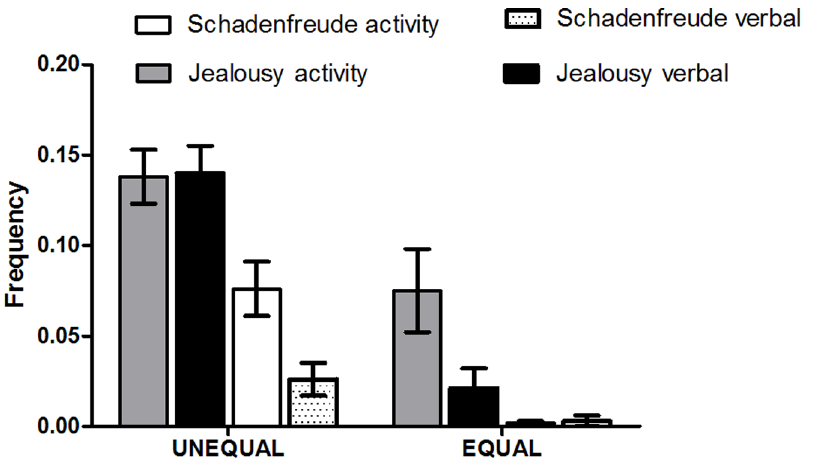
Figure 3. Quantity of different emotional manifestations. A significant interaction of phase (phase 1, phase 2)*condition (EQUAL, UNEQUAL) * category (verbalization/action) . Follow-up paired t tests indicated that the differences between the UNEQUAL and the EQUAL condition were evident in the action phase 1 ratings, verbalization phase 1ratings, in the phase 2 action ratings and phase 2 verbalization ratings.